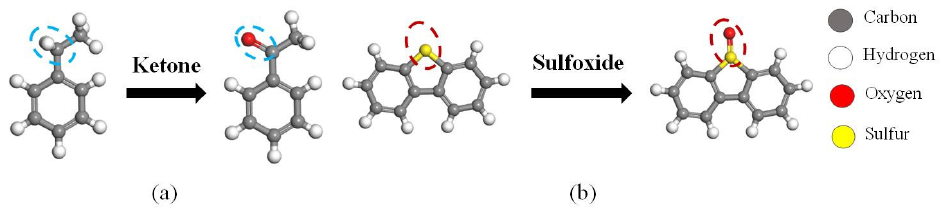
Figure 2. Illustration of major oxidative products in asphalt: ( a ) Ketone group; ( b ) Sulfoxide group.